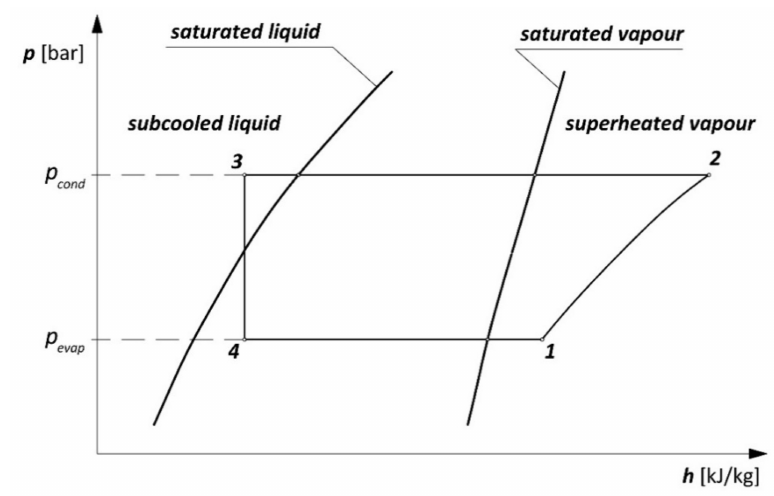
Figure 1. Pressure–enthalpy diagram of a theoretical refrigeration